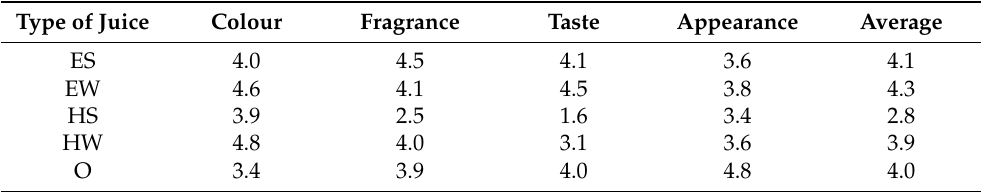
Figure 8. Percentage of respondents who chose a company’s citrus juice. Legend: A–S the type of the juice produced by different Polish companies. Table 1. Organoleptic evaluation of produced juices and commercial